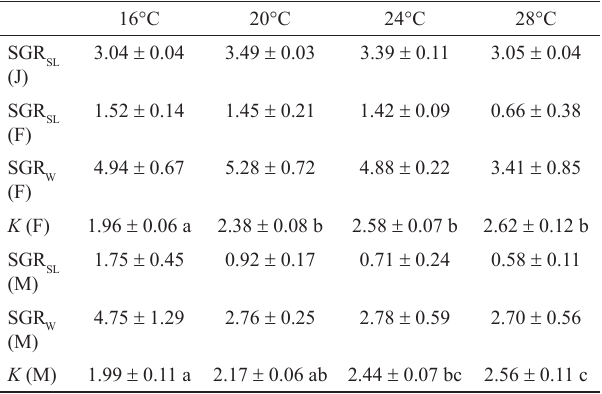
Fig. 2. Standard length (SL) of females (A) and males (B) and weight (W) of females (C) and males (D) (mean ± standard error) Austrolebias wolterstorffi kept in the laboratory for 67 days after hatching (DAH) under different temperatures. Different letters represent significant mean differences between treatments (ANOVA, Tukey, p < 0.05) Table 2. Specific growth rate (mean ± standard error) from mean of the standard length (SGR ) and weight (SGR ) of SL W juveniles (J) (0-39 DAH), males (M) and females (F) (53- 67 DAH) and final values of condition factor ( K ) (mean ± standard error) of Austrolebias wolterstorffi reared during 67 days under different temperatures. Letters denote statistical significance across parameters (ANOVA, Tukey, p < 0.05). DAH = days after